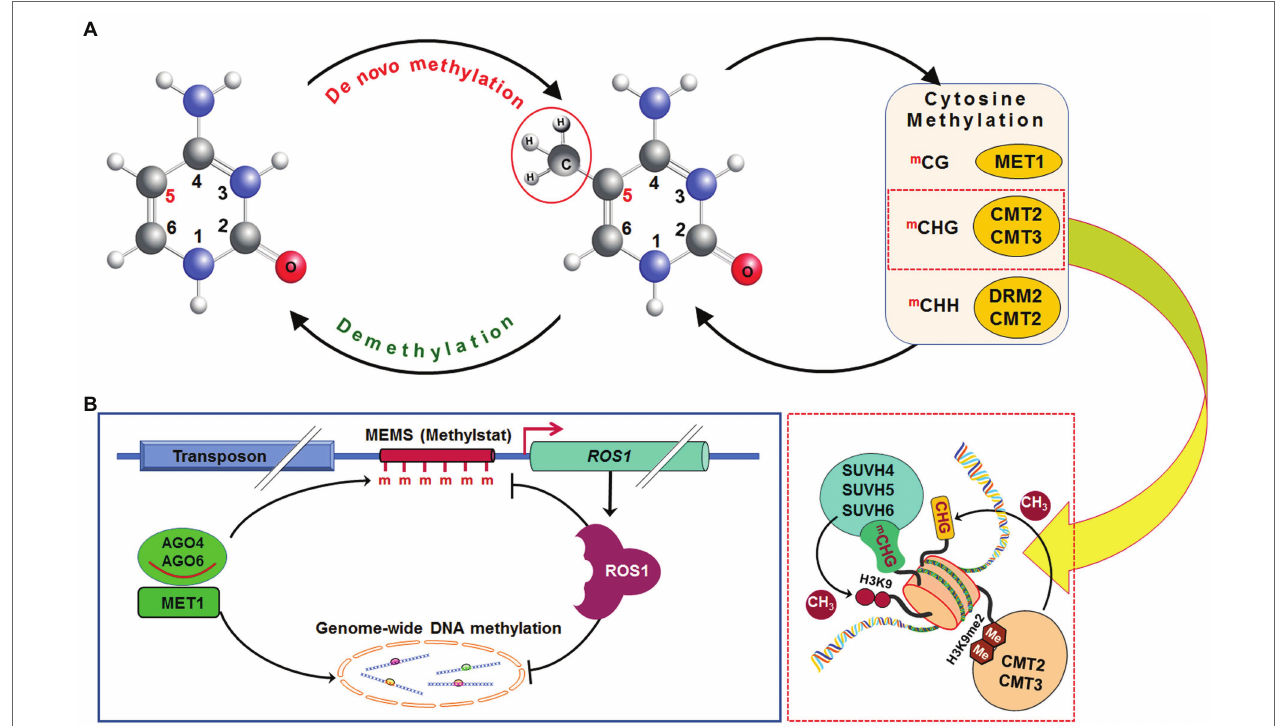
FIGURE 2 | Dynamics of DNA methylation in plants. De novo DNA methylation occurs in all (CG, CHG, and CHH; where H=A, C, or T) cytosine contexts. After replication of DNA, methylation in the CG context is maintained by methyltransferase 1 (MET1), while methylation in CHG context is maintained by chromomethylase 2 (CMT2) or CMT3, and methylation in CHH context is maintained by CMT2 or by DRM2 via RdDM pathway. Methylated CHG ( m CHG) attracts histone H3 lysine 9 (H3K9)-specific suppressor of variegation 3-9 homolog protein 4 (SUVH4), SUVH5, and SUVH6 and generates dimethylated H3K9 (H3K9me2), which enables CMT2 and CMT3 (A) . Methylation of methylation monitoring sequence (MEMS), also known as “methylstat” present in the promoter of the Repressor of silencing 1 ( Ros1 ) is necessary for transcription of the Ros1 gene. Cytosine methylation at MEMS is controlled by MET1/RdDM and Ros1 itself. This helps to sense/monitor the level of methylation and regulate DNA (de)methylation homeostasis (B) . CH 3 , methyl group, Me/m, methylation (Redrawn from Zhang et al.,